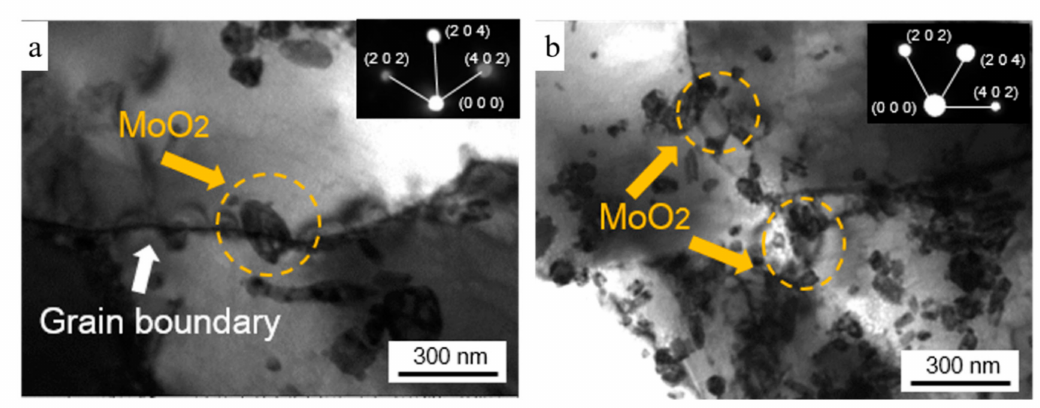
Figure 14. TEM images in the fusion zone of NS Mo alloy welded joints. Heat input: ( a ) 250 J / cm; ( b ) 3600 J /